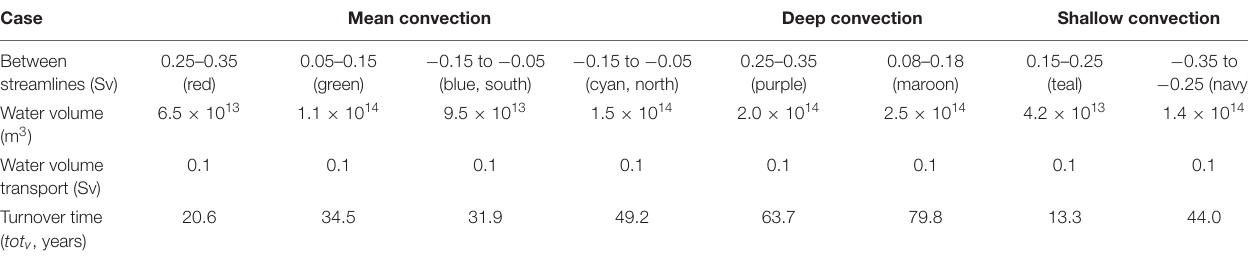
TABLE 3 | Turnover time ( tot v ) for the mean, deep, and shallow convection cases in the ES MOC. Case Mean convection Deep convection Shallow convection Between streamlines